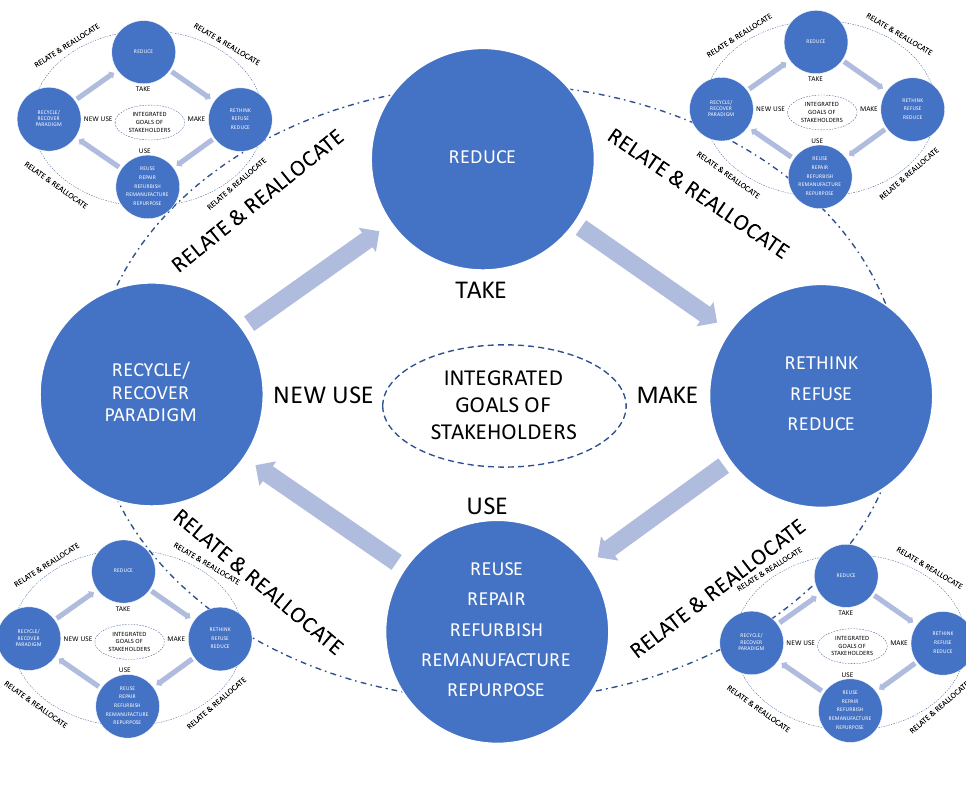
Figure 2: The Relate and Reallocate Paradigm of the